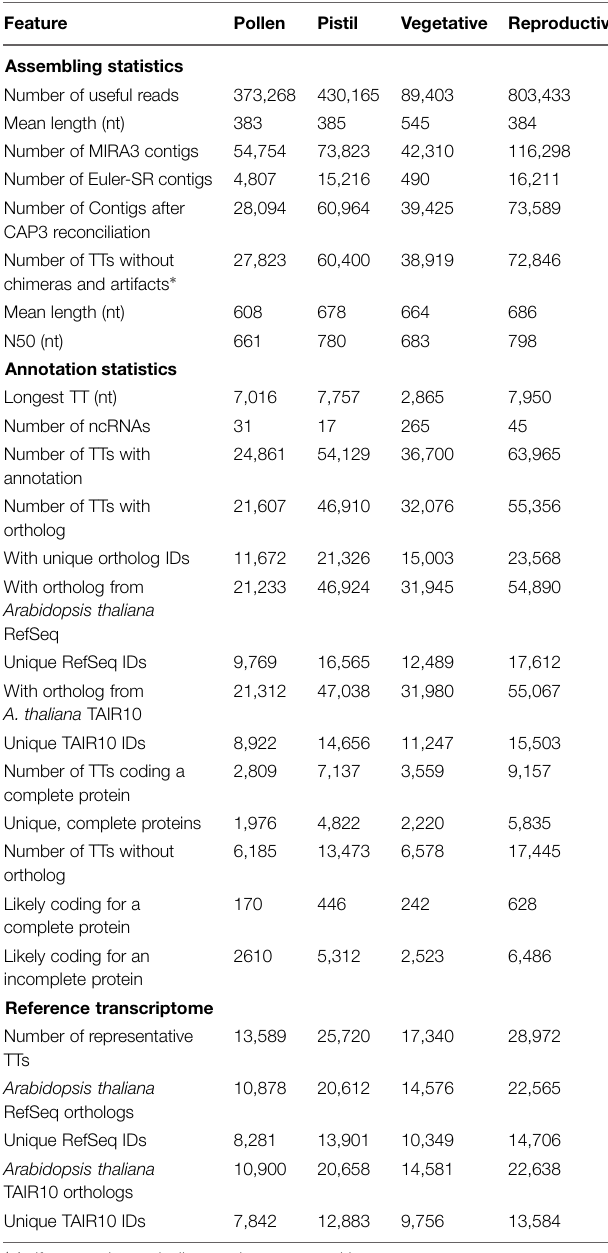
TABLE 2 | Main features of transcriptomes in ReprOlive based on Full-LengtherNext analyses.